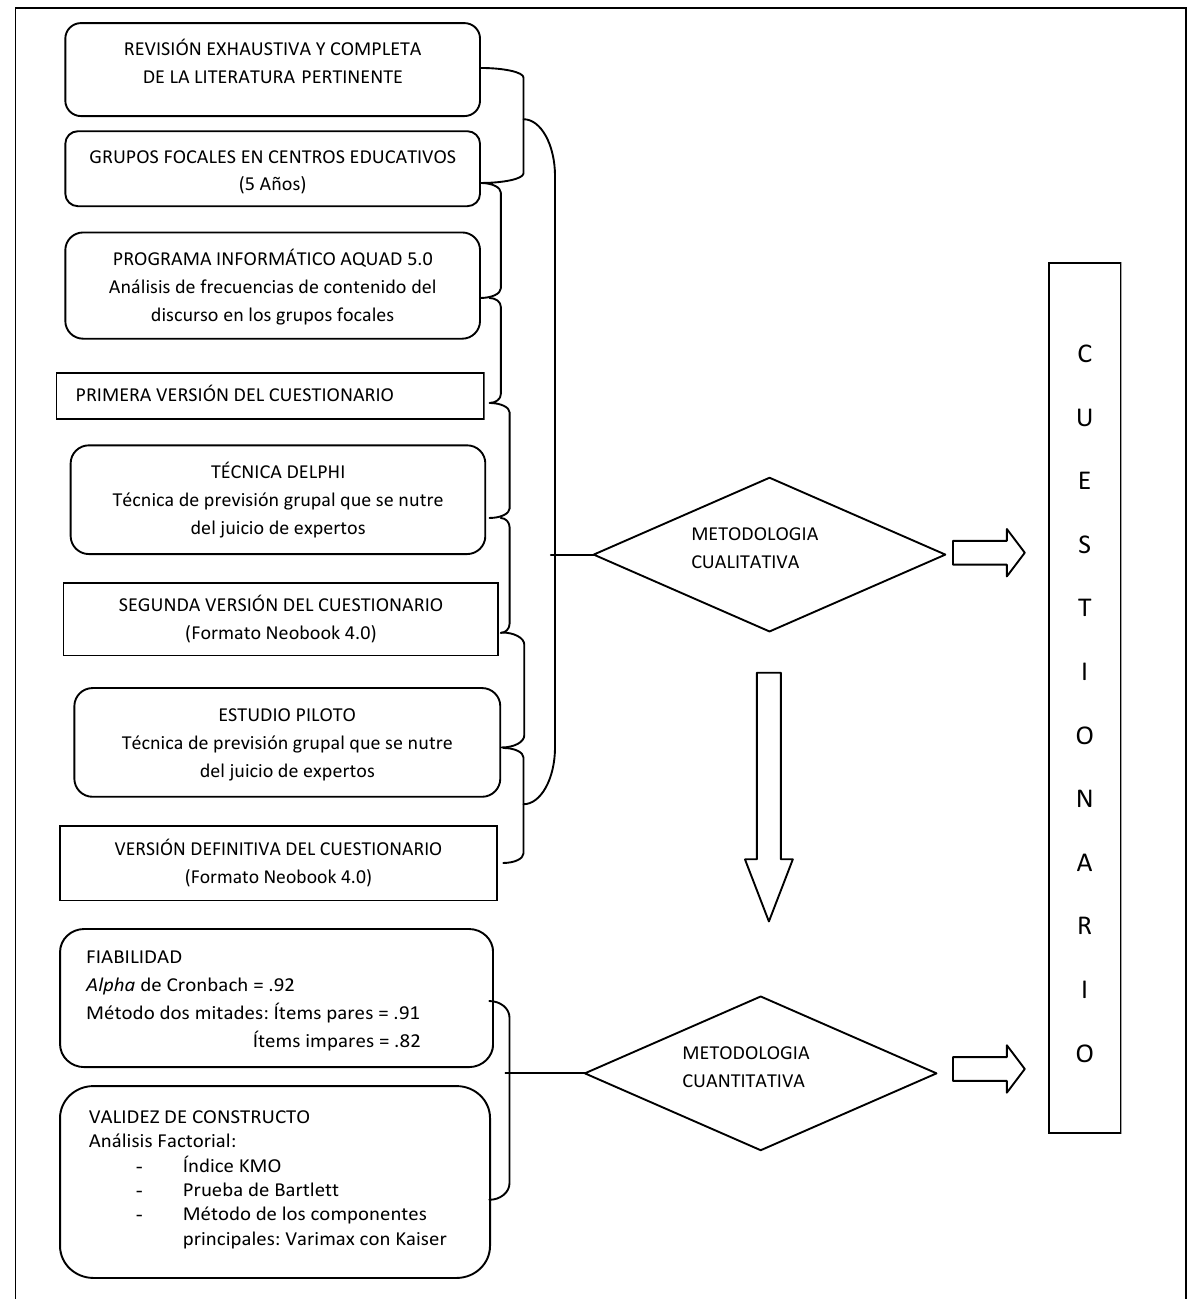
Figura 1 . Esquema del proceso en la elaboración del cuestionario. Nota . Elaboración